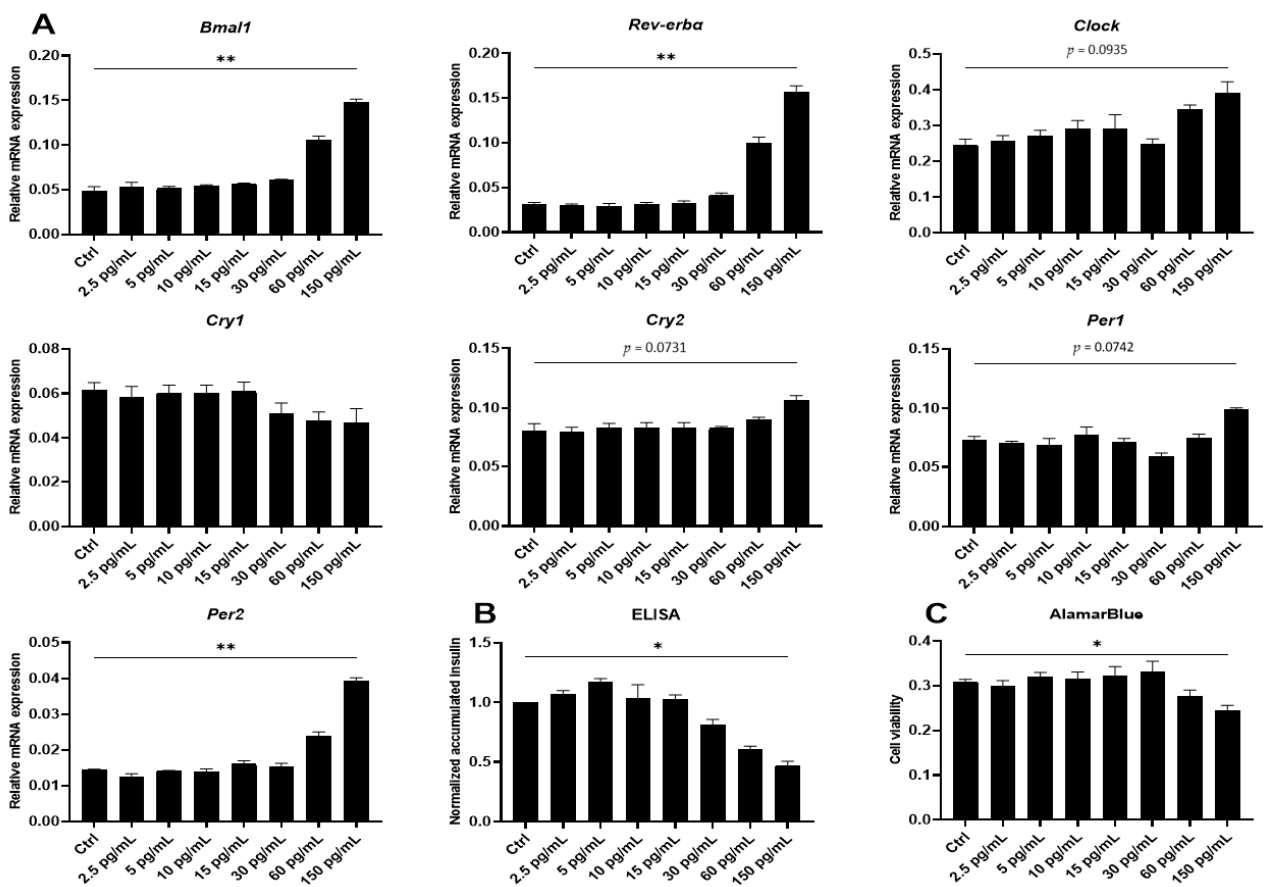
Figure 2. IL-1 β differentially affects clock gene expression in non-synchronized INS-1 cells in a dose-dependent manner, associated with loss of cell function and viability . INS-1 cells were exposed to increasing concentrations of mouse IL-1 β for 12 h. Effects on clock gene expression were evaluated ( A ), while function and cell viability were assessed through quantification of accumulated insulin (ELISA) ( B ) and AlamarBlue ( C ), respectively. Relative mRNA expression is calculated using hypoxanthine-guanine phosphoribosyltransferase ( Hprt1 ) and β -Actin as reference genes. Values are means ± SEM ( n = 3). Statistics are repeated measures one-way ANOVA with the p -values represented by symbols above the line. Significance levels were annotated as follows: * = p -value < 0.05, ** = p -value <